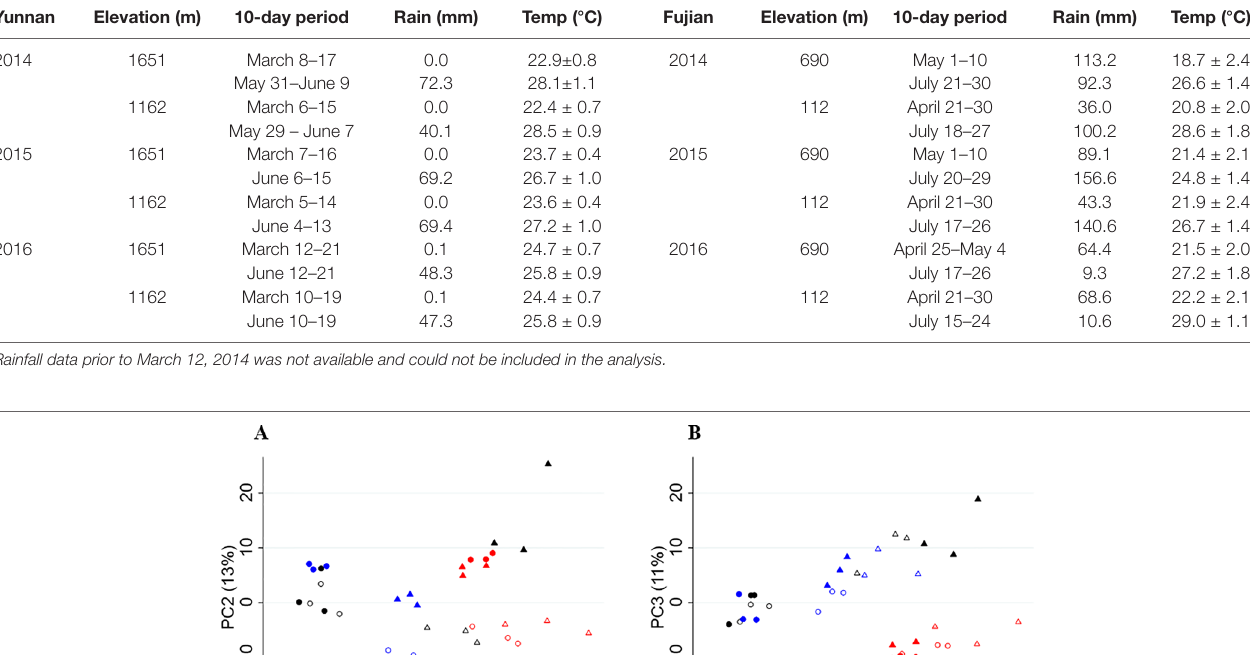
TaBLE 1 | 10-day cumulative rainfall and average temperature prior to each harvest (Huffman et al., 2014; CPC, 2018). Yunnan Elevation (m)